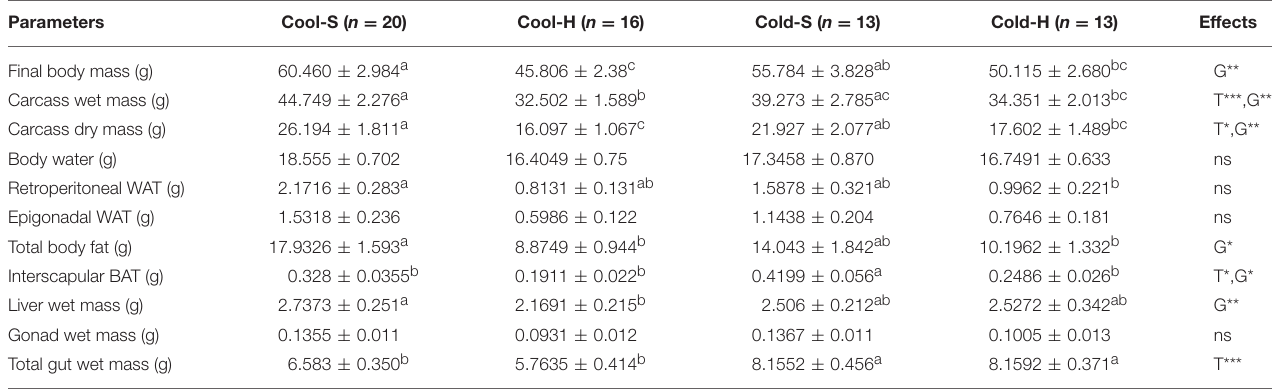
TABLE 2 | Effects of T a and grouping condition on body composition of voles from different groups.